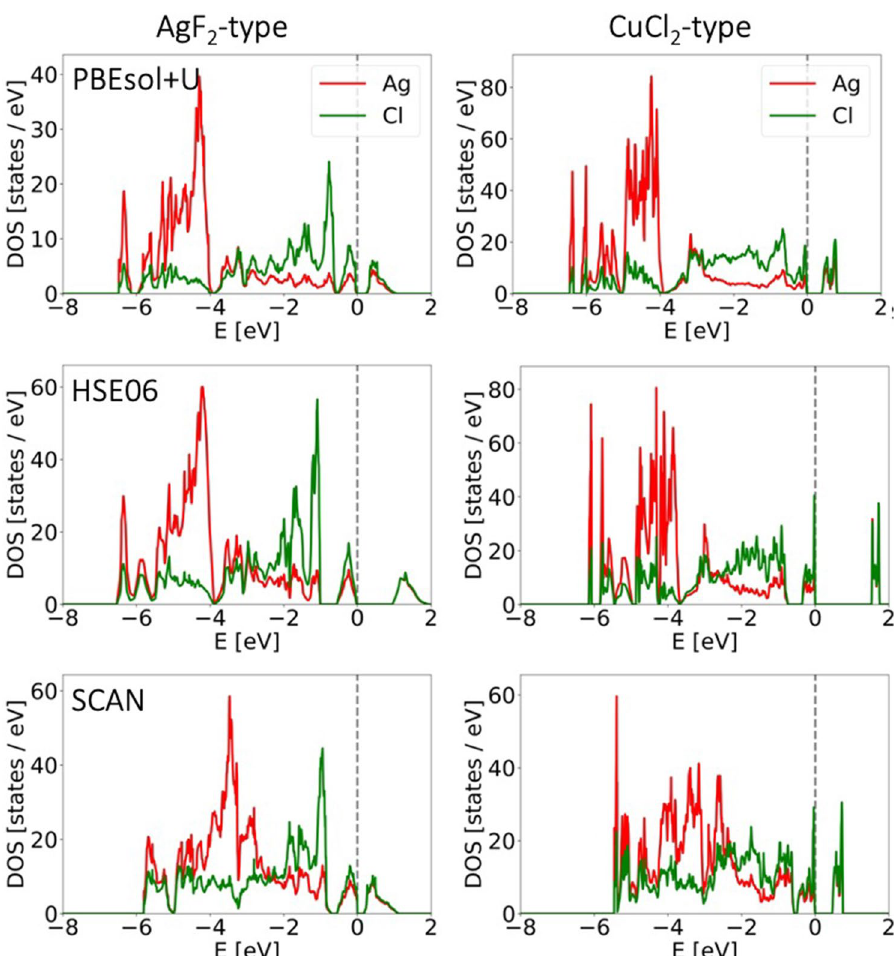
Figure 13. Comparison of eDOS plots for AgF 2 -type and CuCl 2 -type between different computational methods at 0